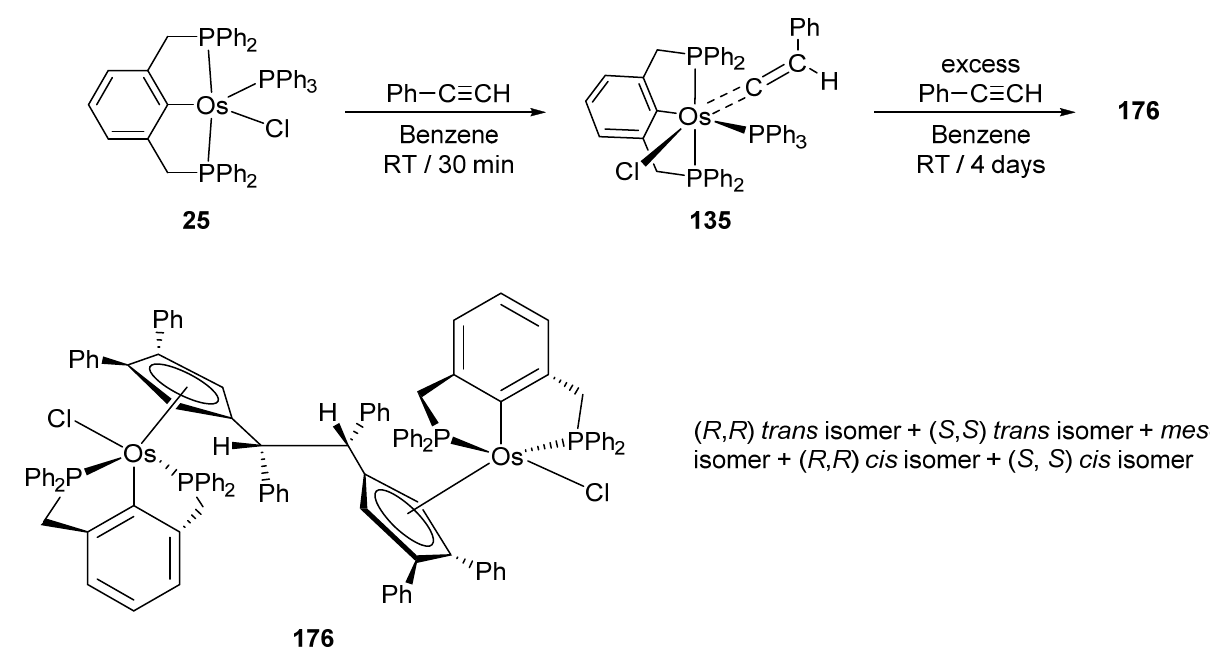
Figure 38. Hexamerization of phenylacetylene at osmium pincer complex.